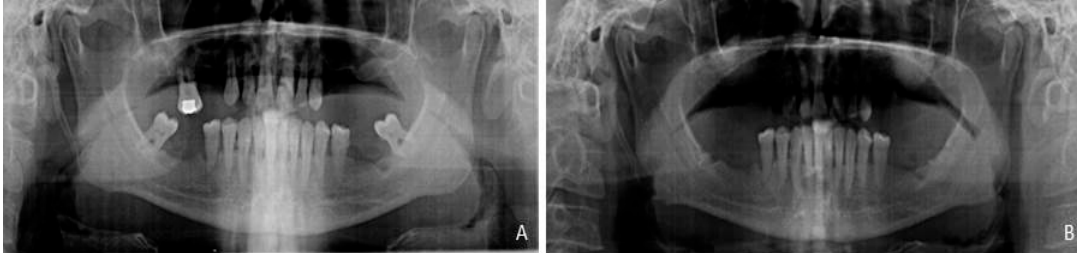
Figure 5. ( A ) Preoperative panoramic image before the sinus lift; and ( B ) postoperative panoramic image 6 months after the sinus lift.